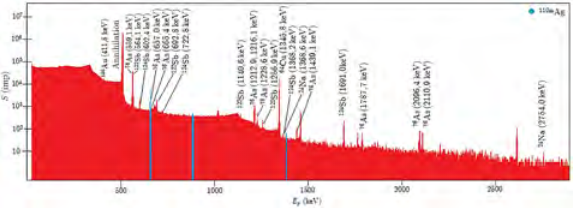
Table 1. Reaction rates of irradiated activation de- tectors. Figure 5. Analyzed gamma spectrum of